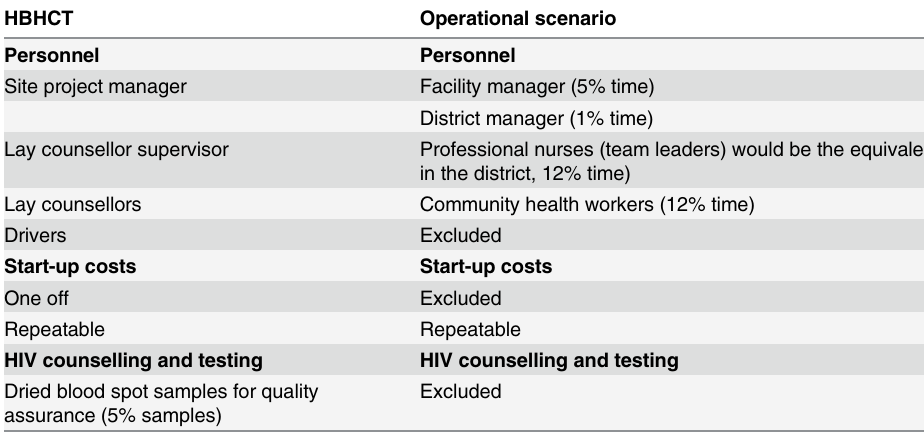
Table 2. Description of inputs varied in the operational